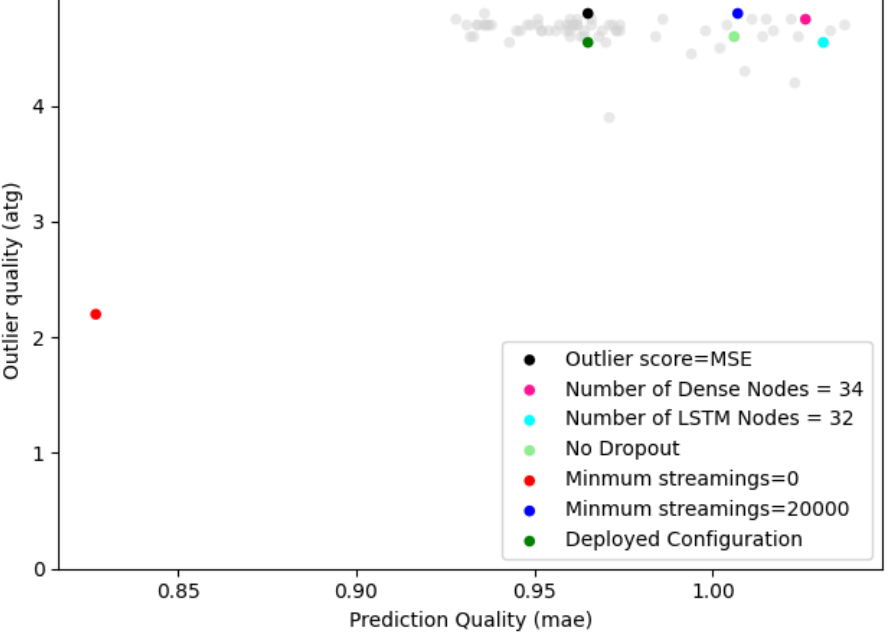
Figure 4. The deployed configuration has 16 LSTM nodes, 8 Dense nodes, a 0.5 dropout layer, 15,000 training samples, 2000 epochs, minimum streams in sample is 10,000, and the outlier calculation used is mean absolute error. We have plotted all the experiments we have executed to reveal the relation between precision ( mae ) and outlier quality ( atg ). Additionally we have labeled interesting changes to